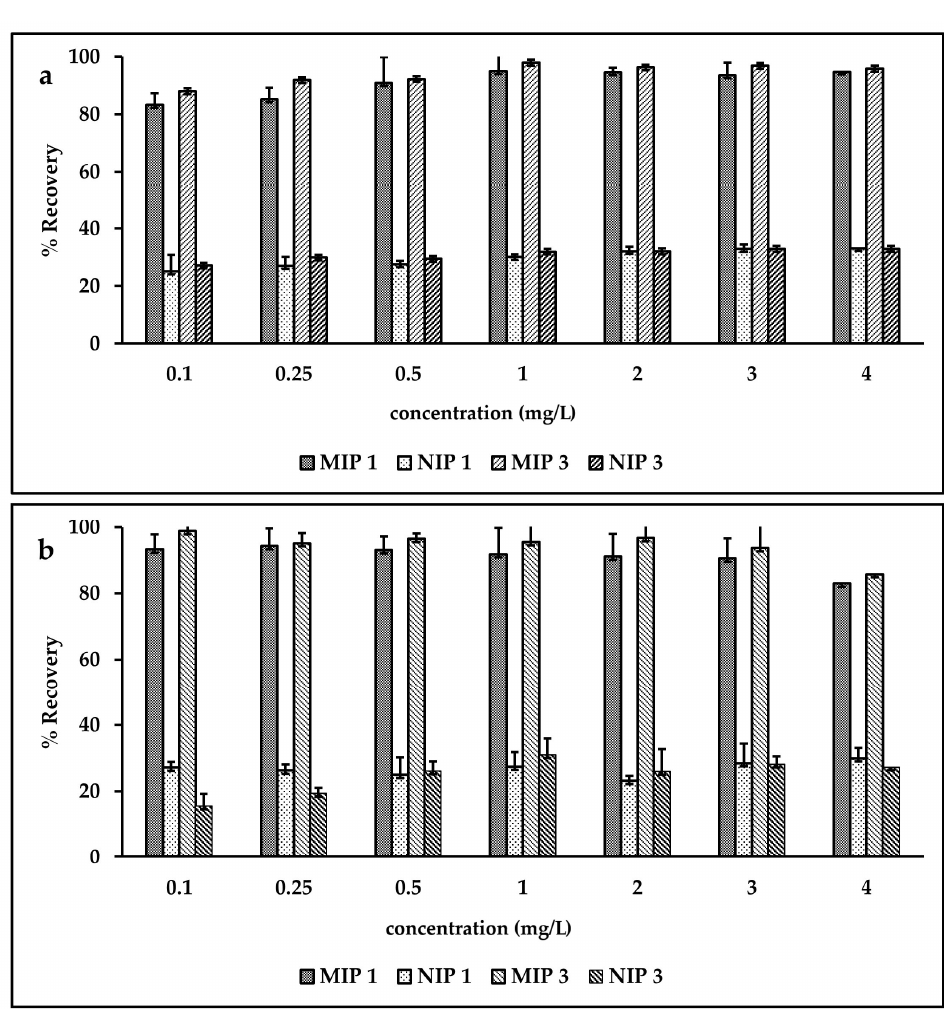
Figure 6. Effect of SLX concentration on % recovery: ( a ) loading using isopropanol, ( b ) loading using water.